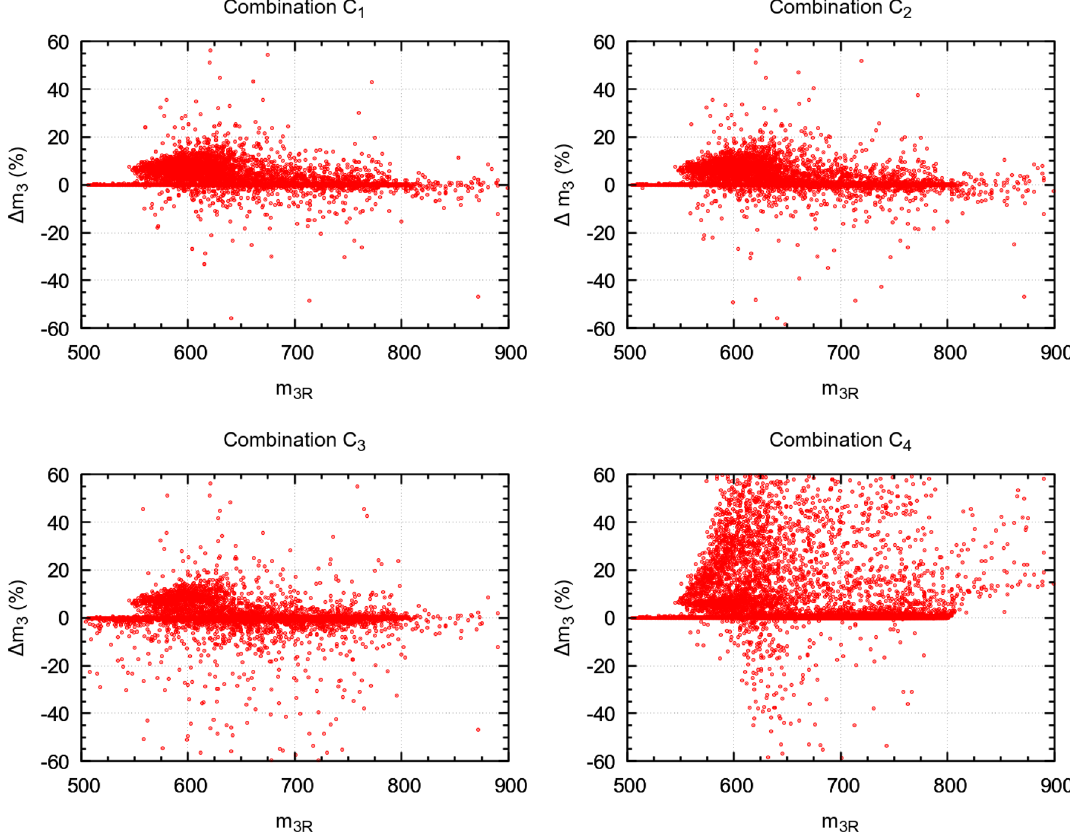
Figure 1. The quantity ∆ m 3 defined in eq. (2.15) for the different combinations: C 1 (top left), C 2 (top right), C 3 (bottom left) and C 4 with µ R = 350 GeV (bottom right). Only the range − 60% < ∆ m 3 < 60% is